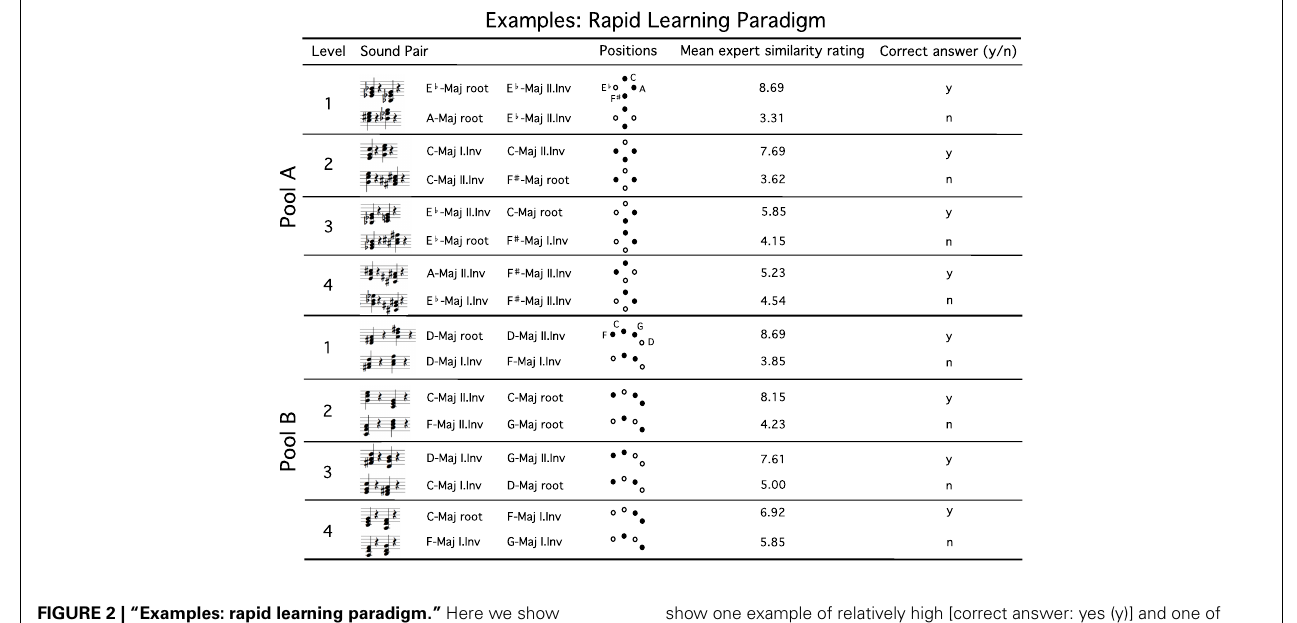
FIGURE 2 | “Examples: rapid learning paradigm.” Here we show representative examples of sound pairs (sequential order of sounds is arbitrary) presented in the rapid learning paradigm, for both pools (A/B) and each level (1–4) of difficulty.The positions within the expert maps are schematically displayed: dots correspond to clusters of each tonality, the position of sounds correspond to the white dots. In case of only one white dot, both sounds belong to the same tonality. For every level we